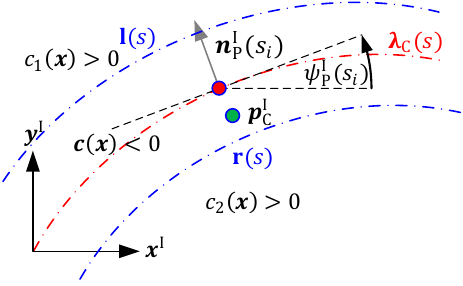
Figure 5. Graphical analysis of the street boundary calculation.